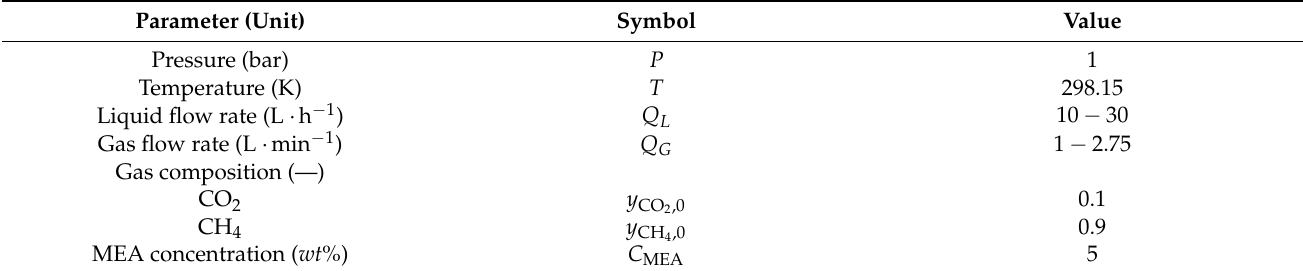
Table 3. Operating conditions of HFMC [26].